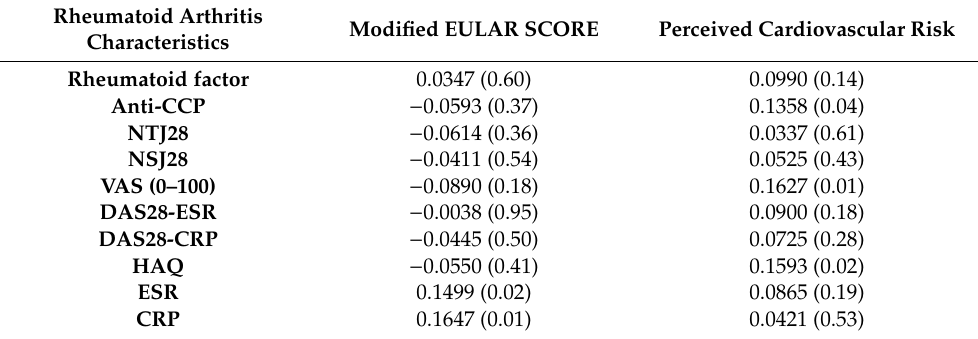
CCP: citrullinated peptides, CRP: ultra-sensitivity C- reactive protein, DAS28: Disease Activity Score in 28 joints, ESR: erythrocyte sedimentation rate, HAQ: Health Assessment Questionnaire, NST: number of swollen joints, NTJ: number of tender joints, VAS: visual analogic scale.